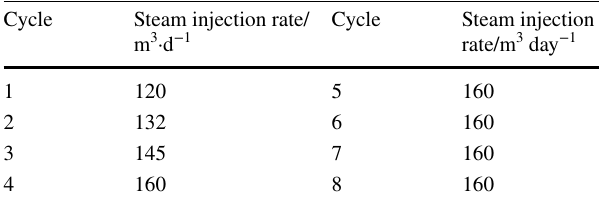
Table 3 Steam injection rate of each cycle Cycle